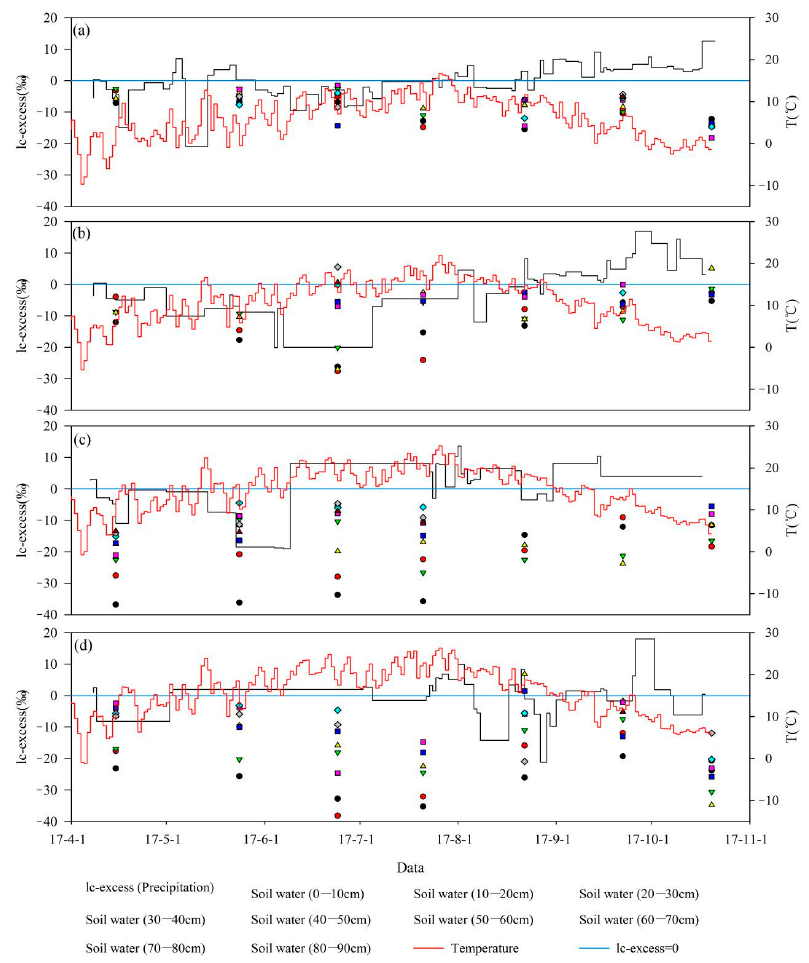
Figure 4. Temperature, line-conditioned excess (lc-excess, in ‰) values for water samples of soil water at different depths and precipitation at the four stations in the study area (( a ) Lenglong; ( b ) Ningchan; ( c ) Huajian; ( d ) Xiying).